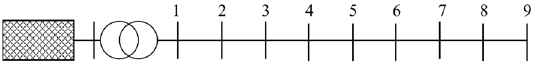
Figure 20. Single-line diagram of the 9-bus test network. Table 8. Load data of the 9-bus test network.